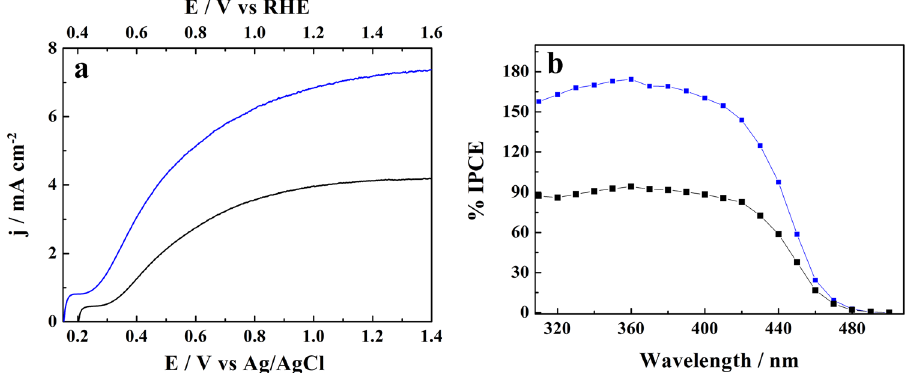
Fig. 7 Effect of glucose addition upon photoelectrochemical characteristics of a ~ 3 μ m thick fi lm WO 3 electrode. The measurements were performed in a 0.5 M NaCl of pH 4 solution alone and after addition of 0.1 mol L − 1 of glucose. a Photocurrent densities vs imposed potential (j-E) plots recorded under simulated AM 1.5 G irradiation. b The corresponding IPCE